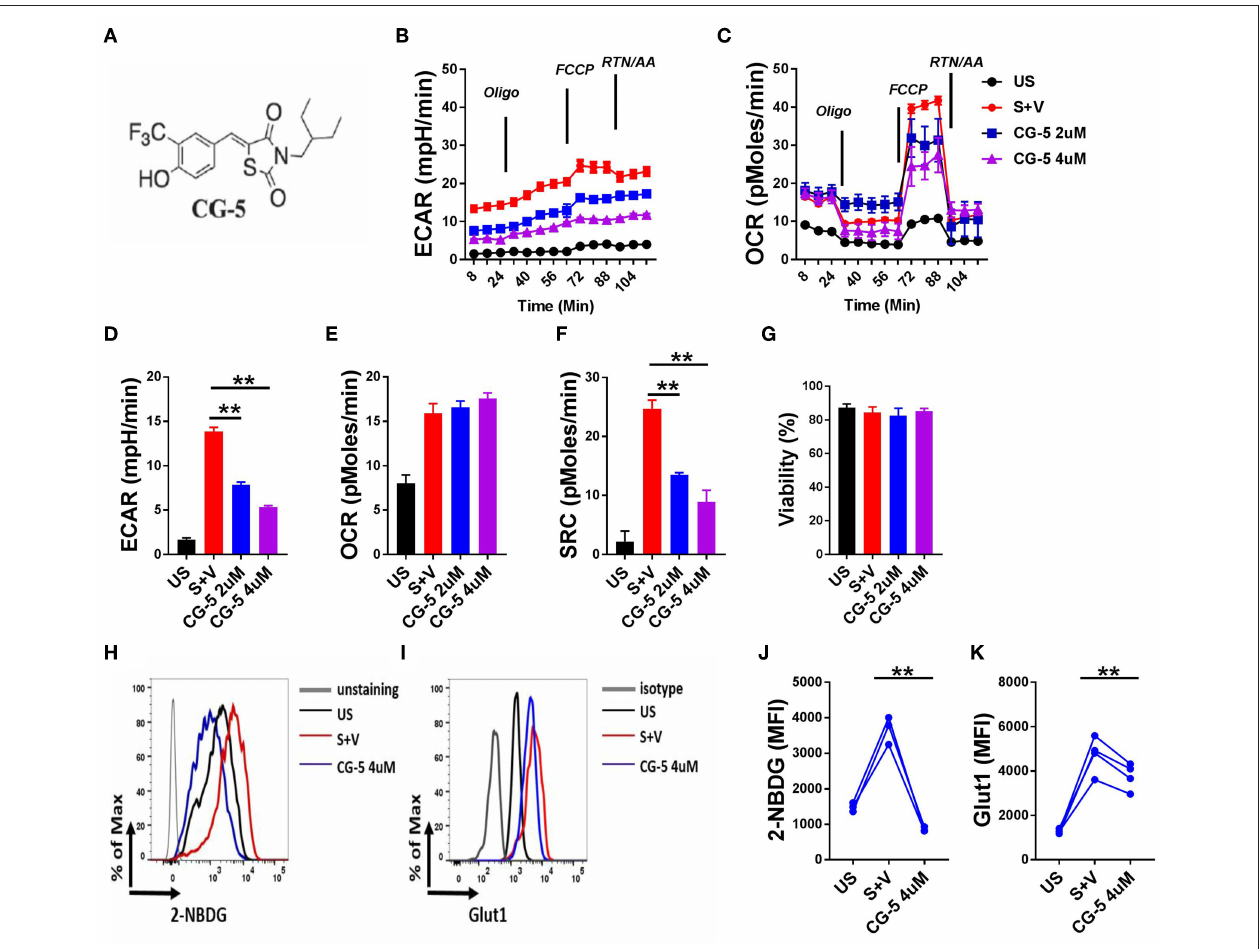
FIGURE 1 | CG-5 inhibits glycolysis in murine CD4 + T cells. (A) Chemical structure of CG-5. Cells were either unstimulated (US) or stimulated with anti-CD3/CD28 mAbs for 24h (S) in the presence of vehicle (V), or 2 or 4 µ M CG-5. ECAR (B) and OCR (C) in CD4 + T cells under basal conditions and in response to sequential addition of oligomycin, fluorocarbonyl cyanide phenylhydrazone (FCCP), rotenone (Rtn), and antimycin A (AA). Basal ECAR (D) , OCR (E) , SRC (F) , and cell viability (G) corresponding to (B,C) . 2-NBDG uptake (H , J) and Glut1 expression (I , K) . Representative FACS plots (H , I) of mean fluorescence intensity ( MFI) quantified in ( J , K) . Mean ± S.E.M of n = 3–4 per group compared with S + V values using one-way ANOVA. ** p <